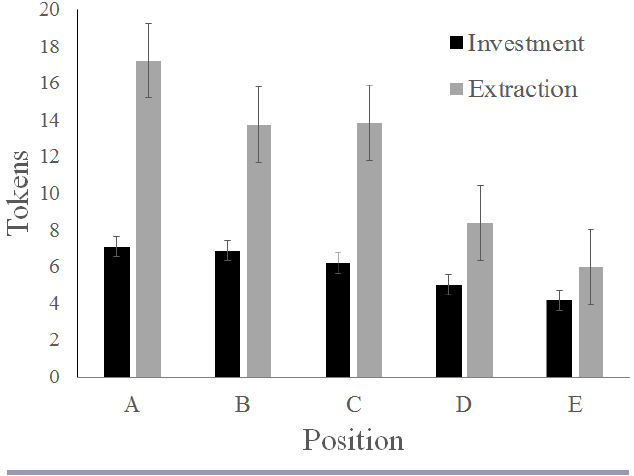
Fig. 6 . Average tokens invested and extracted depending on position (thin bars represent standard